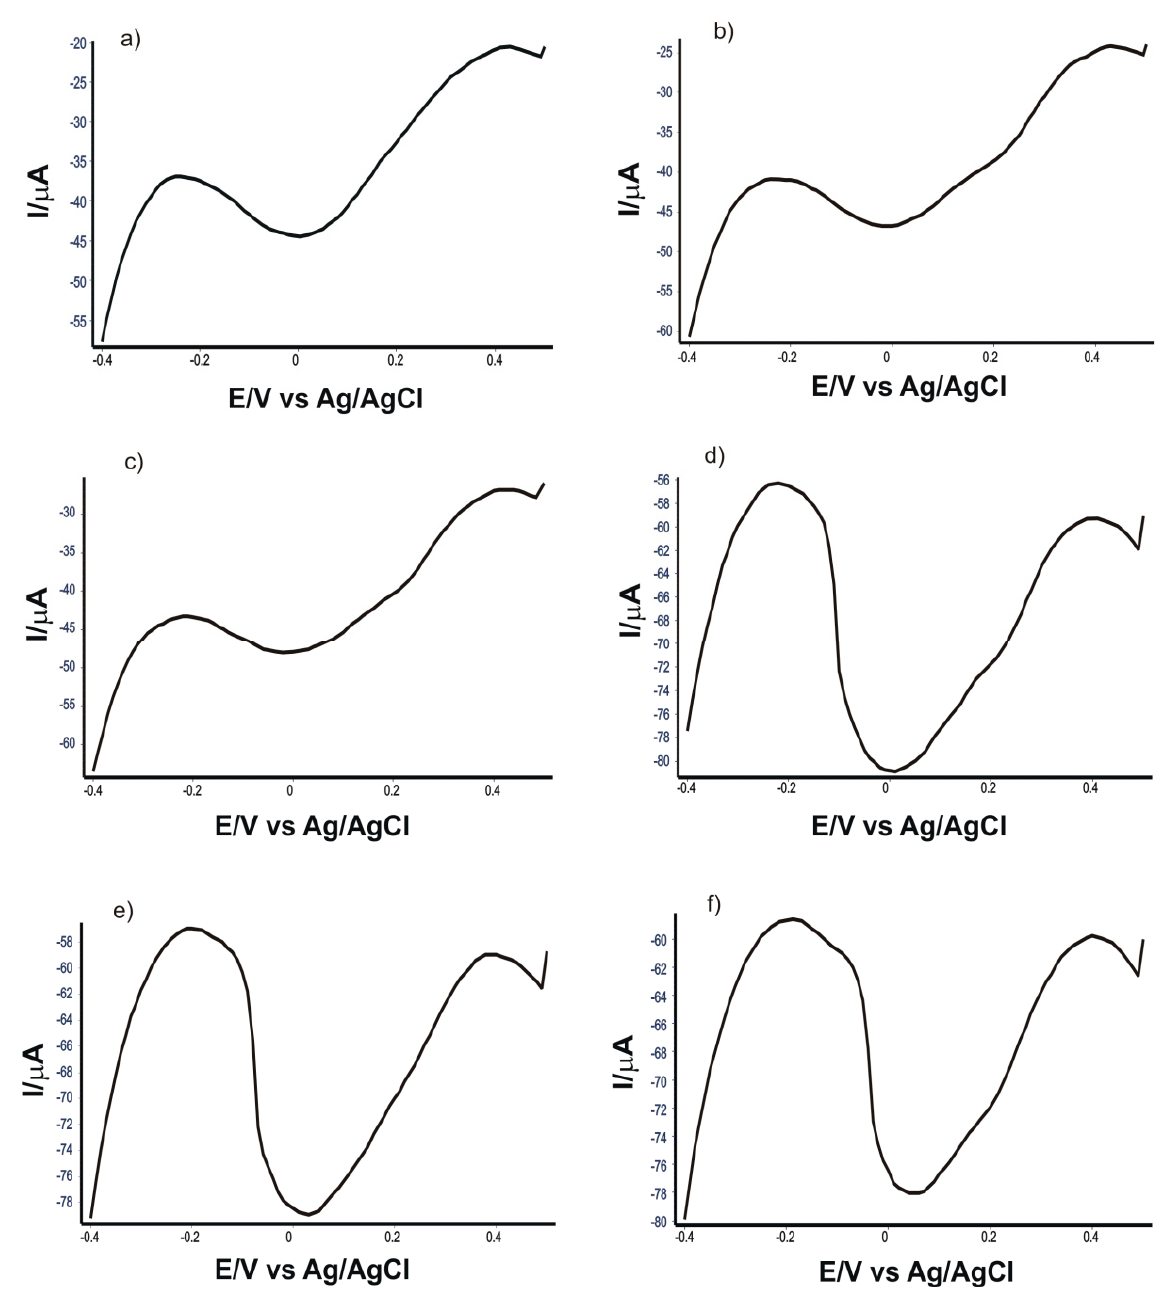
Figure 10. Square wave voltammograms of SPE-SWCNT-Ty immersed in solutions obtained from the 6 EVOOs selected for analysis: ( a ) Solaris, ( b ) Monini mini, ( c ) Costa D’oro Italiano, ( d ) Mueloliva, ( e ) Top Seller and ( f ) Regina Extra.